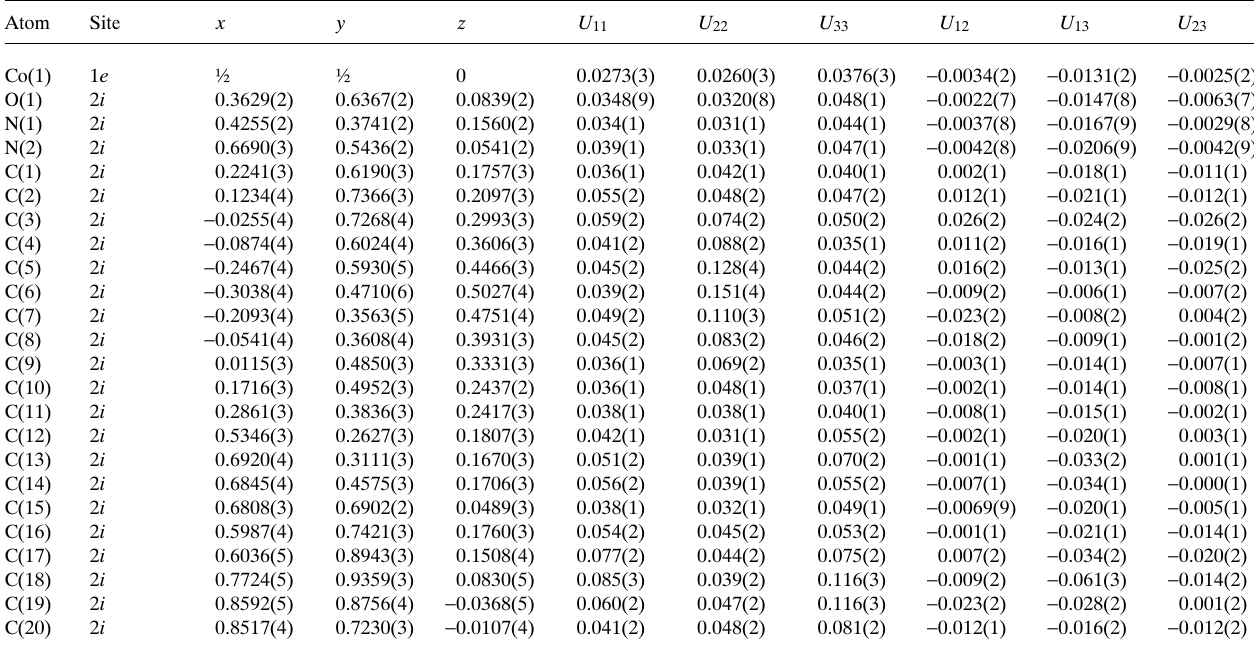
Table 3. Atomic coordinates and displacement parameters (in Å 2 ) .